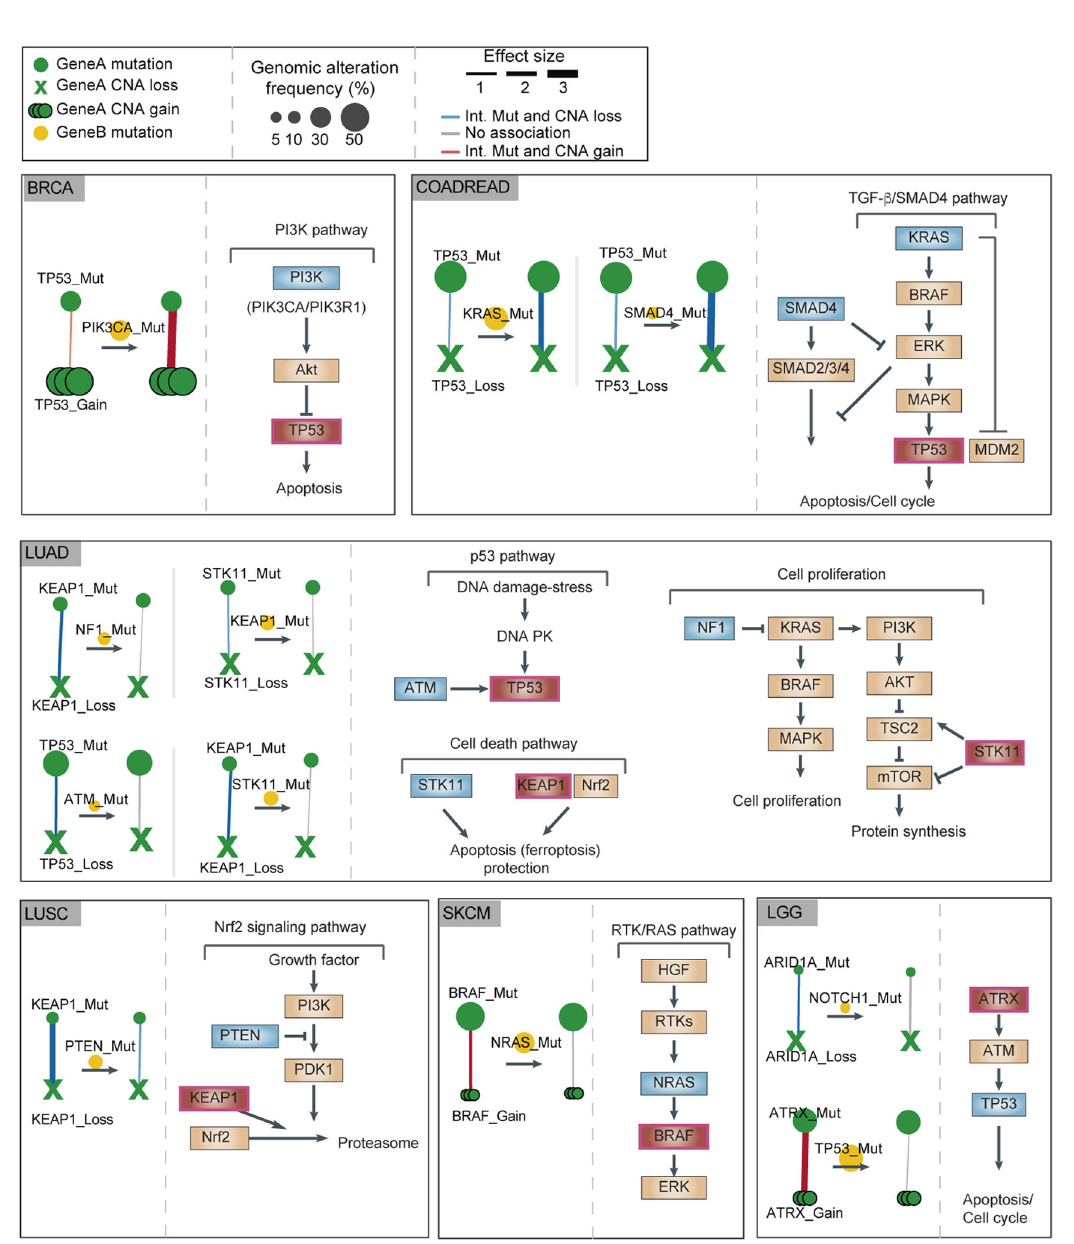
Fig. 4 Mutations that switch genes from two-hit to one-hit drivers in six cancer types. Changes in the strength of interaction between mutations and CNAs in driver genes ( ‘ gene A ’ ) in the absence or presence of mutations in a second cancer gene ( ‘ gene B ’ ). A summary of the pathway in which the function of the gene is also